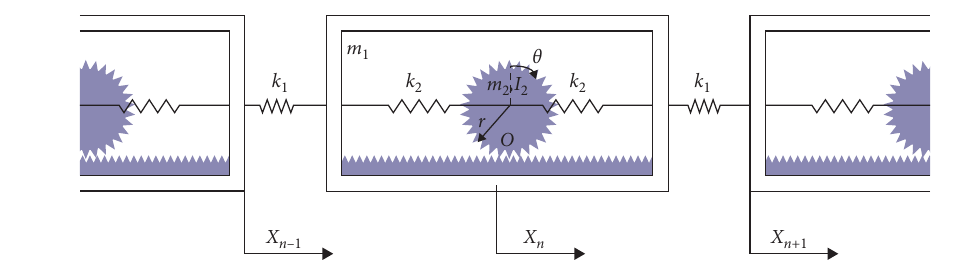
Figure 2: A schematic of a unite cell of the 1DOF